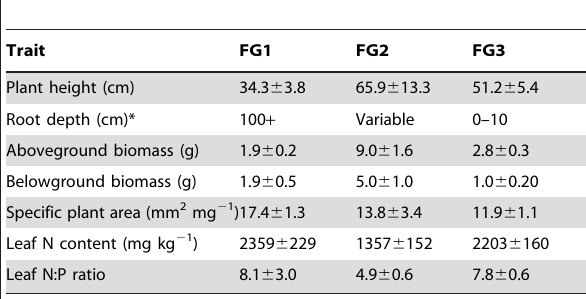
Table 1. Trait means for each functional